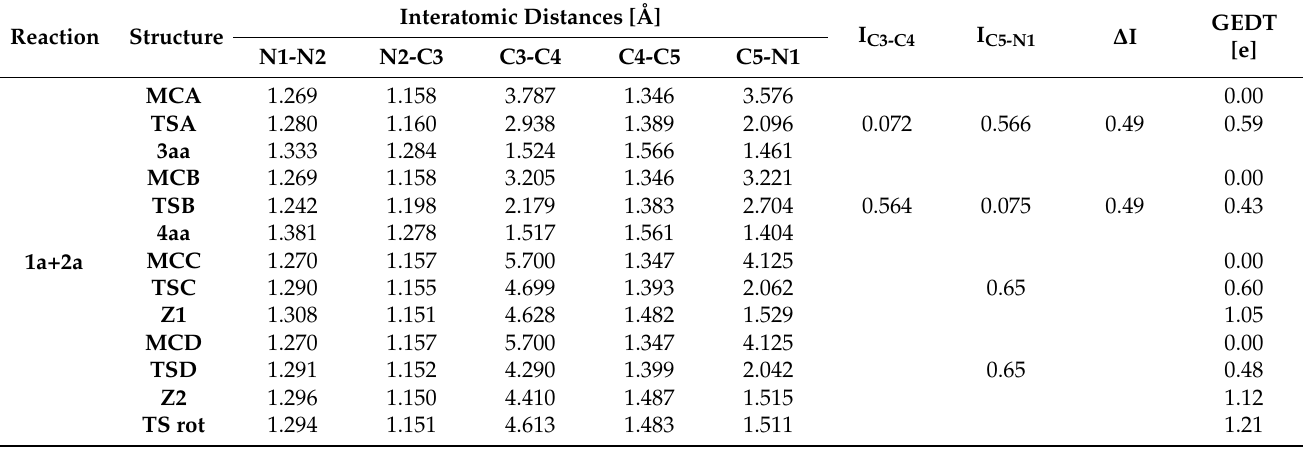
Table 5. Selected parameters for the key structures of the 32CAs of diarylnitrylimines 1a – e and ACNs 2a – c , in nitromethane, obtained from DFT